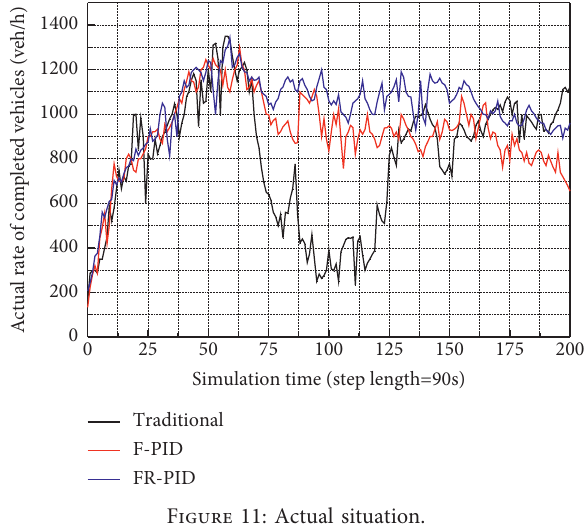
Figure 11: Actual